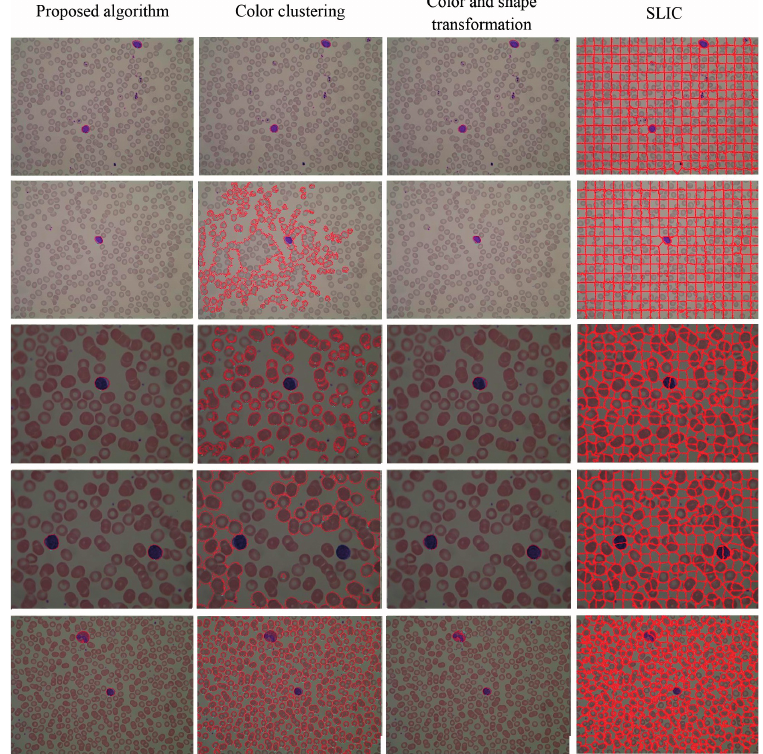
Figure 19. Segmentation results of normal images in the ALL-IDB1 dataset (segmented WBCs marked with red